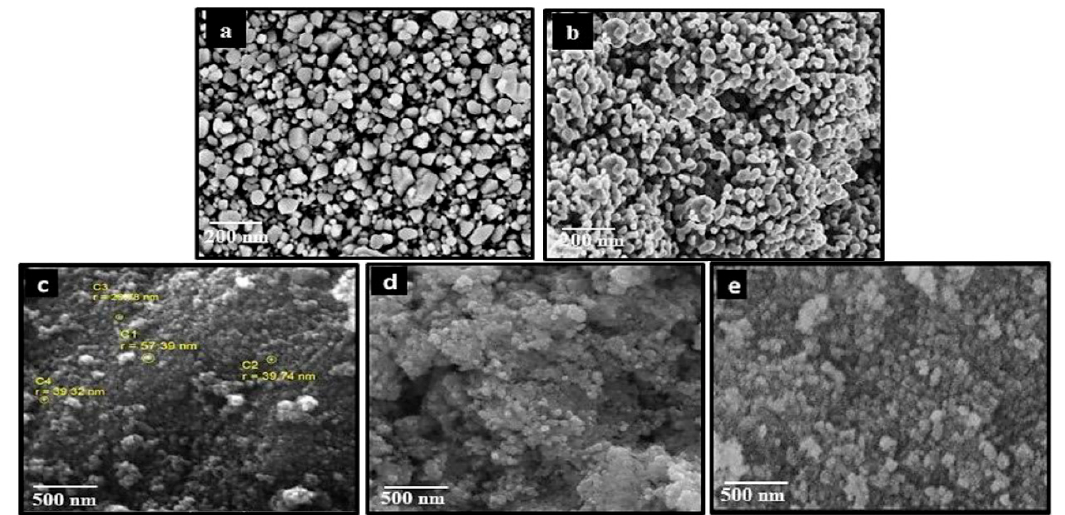
Figure 2. SEM images of ( a ) Bi 2 O 3 ; ( b ) CoFe 2 O 4 ; ( c ) NC-1; ( d ) NC-2; ( e )